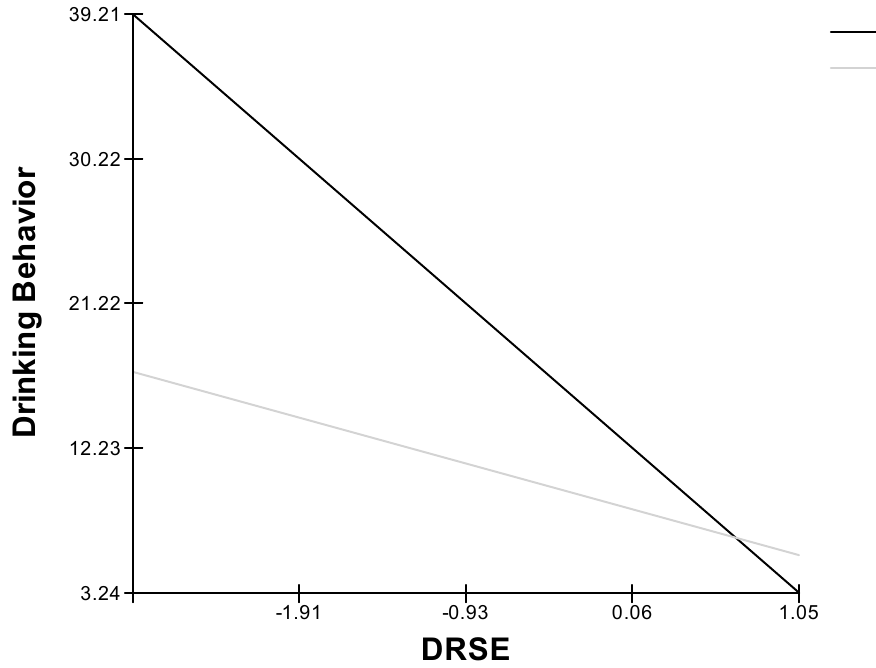
Figure 3. Cross-level two-way interaction effect for drinking behavior (DRSE: Drinking refusal self-efficacy; BPS: Protective behavioral strategies).